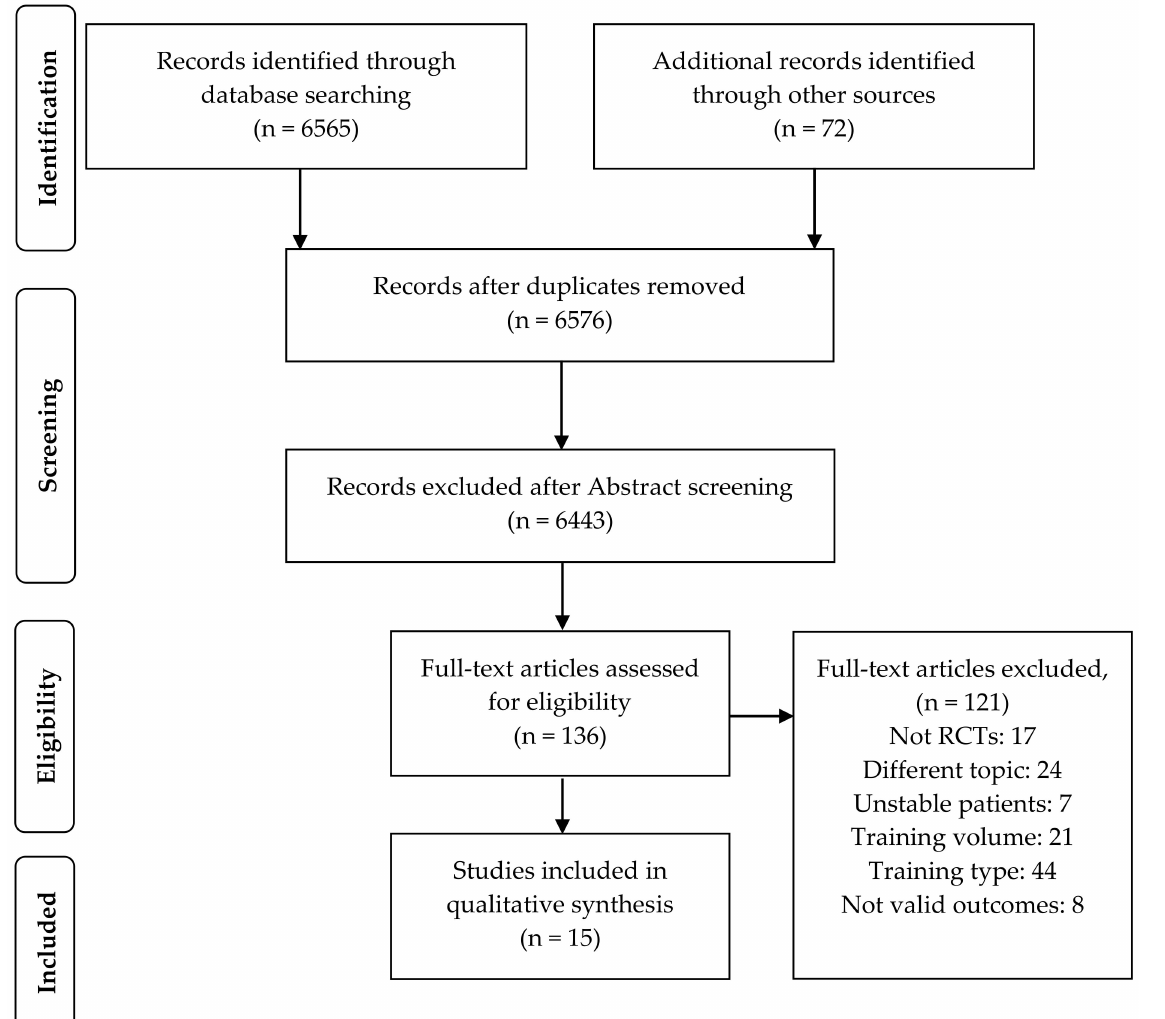
Figure 1. Flow diagram of the study selection. RCTs, randomized controlled